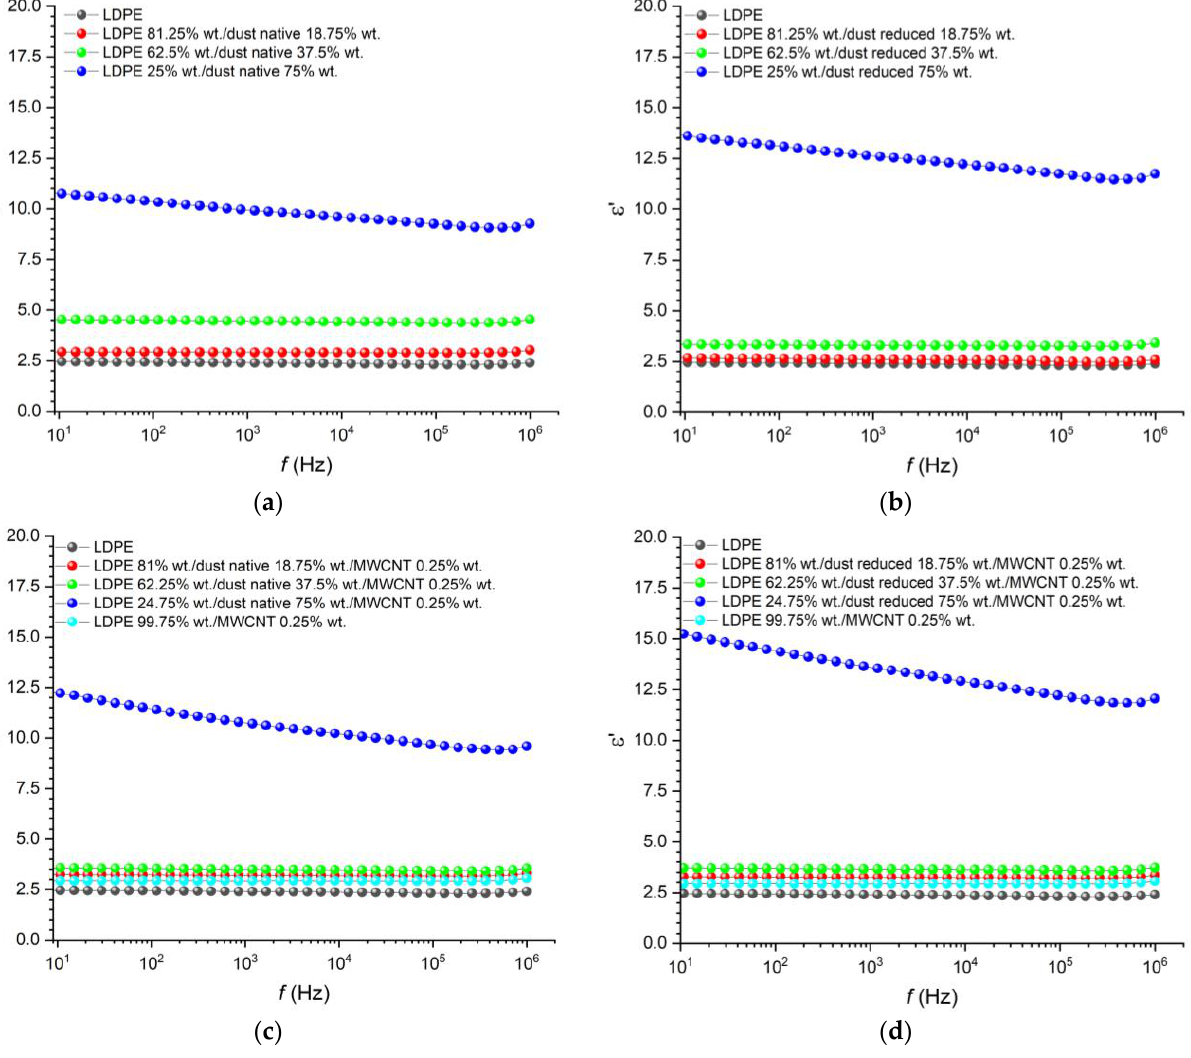
Figure 4. The frequency dependence of permittivity of composite films based on LDPE filled with ( a ) native dust, ( b ) reduced dust, ( c ) native dust /MWCNT, and ( d ) reduced dust /MWCNT.